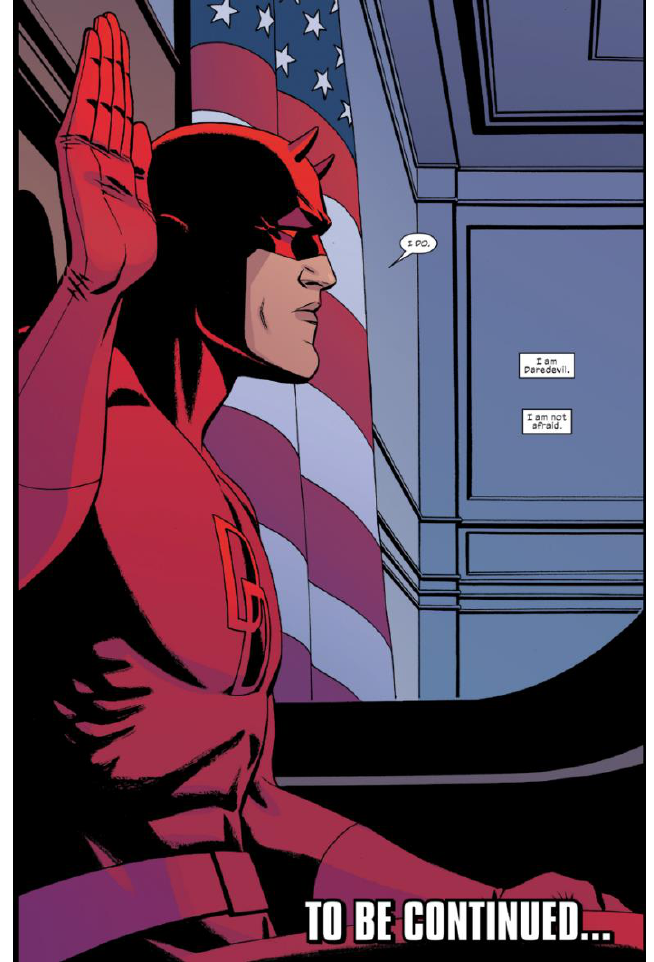
Figure 6. Page from Soule’s Daredevil: Back in Black Vol. 5: Supreme #21, 2017. Image Credit: Goran Sudžuka © 2017 Marvel Characters,